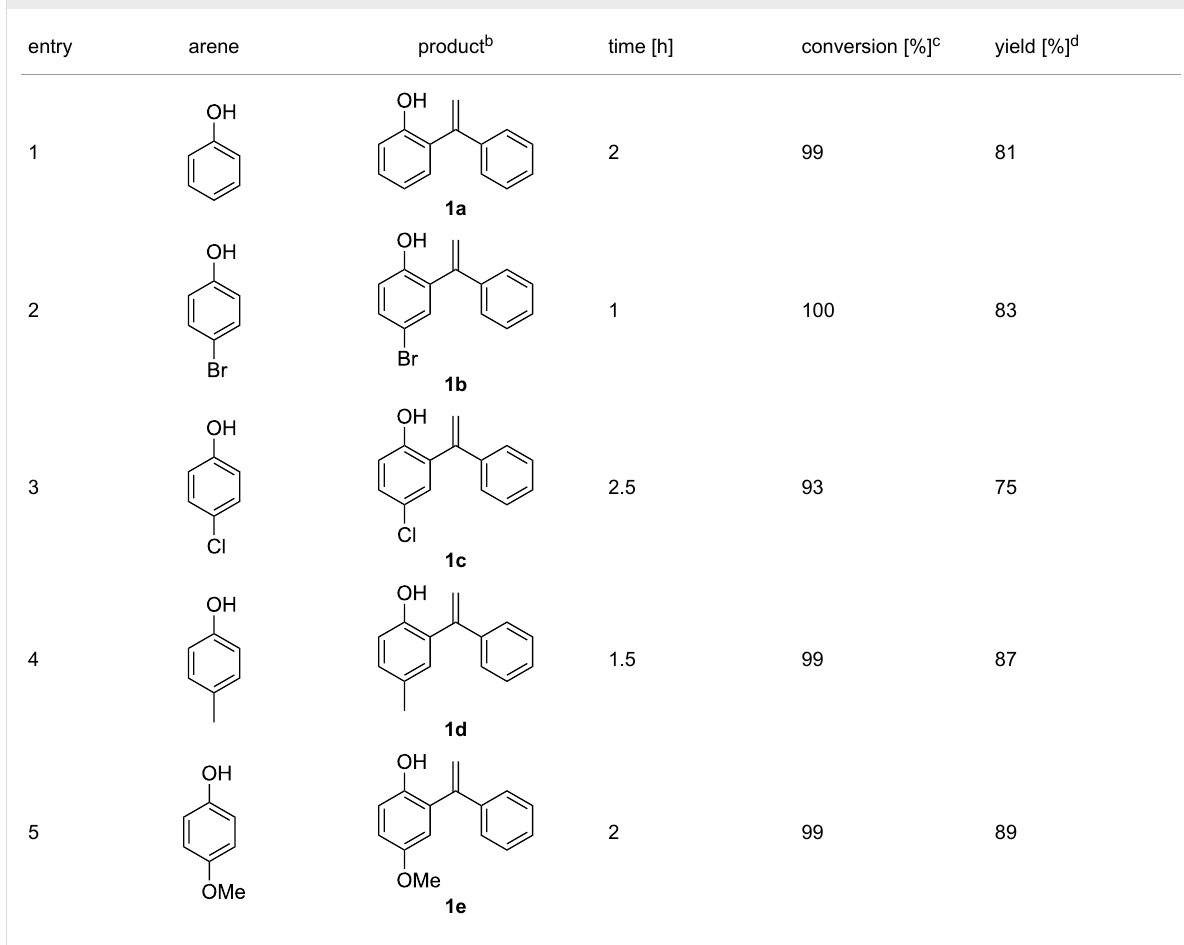
Table 3: Reactions of arenes with phenylalkynes a